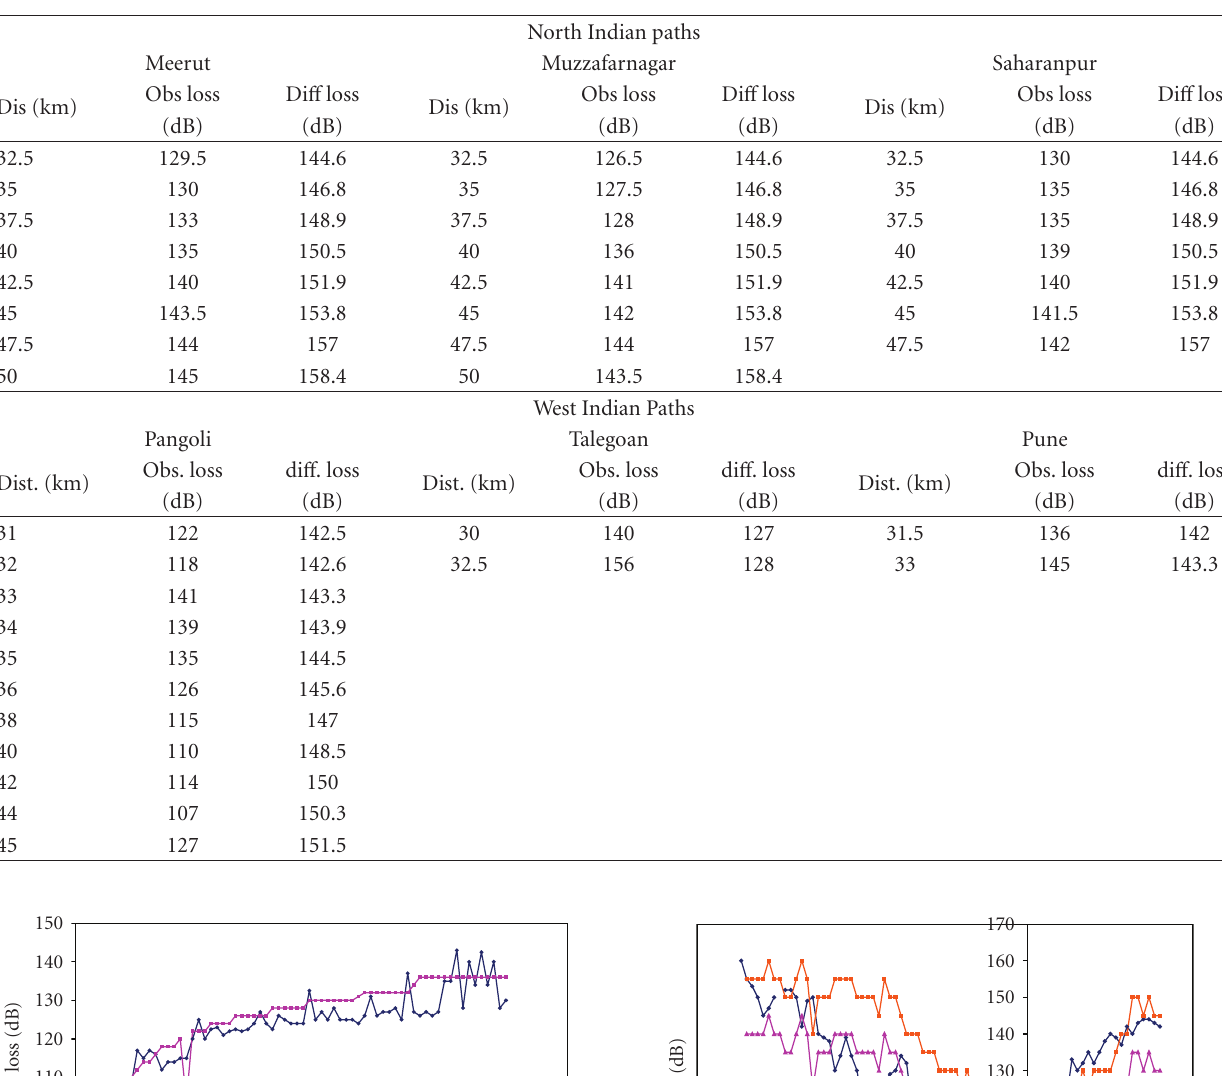
Table 2: Computed and observed di ff raction losses for north and west Indian paths (dB).